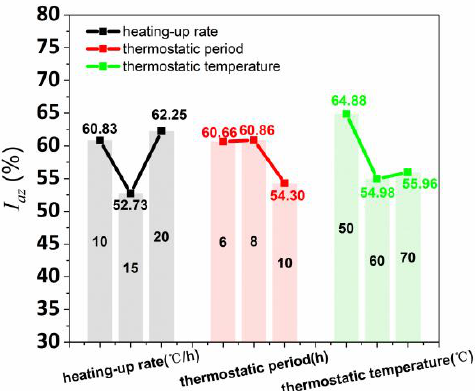
Figure 11. I az affected by various heating-up rates, thermostatic periods, and thermostatic tempera- tures.